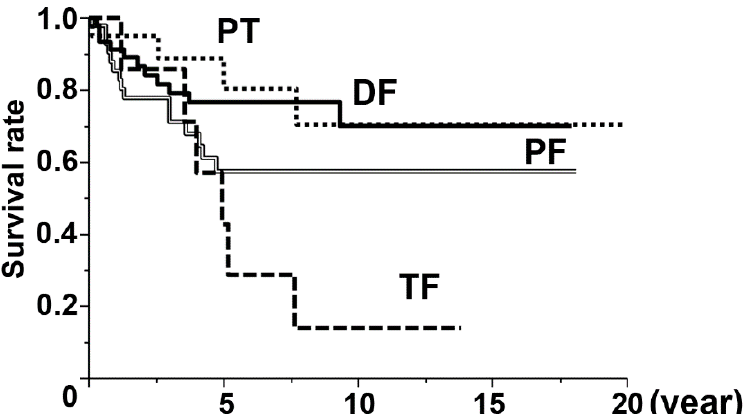
Figure 1. Overall survival of 121 patients who underwent each type of tumor prosthesis. The 5-year and 10-year survival rates were 43% and 14% (Total Femur [TF], long dotted line), 58% and 58% (Proximal Femur [PF], double line), 76% and 70% (Distal Femur [DF], solid line), and 81% and 71% (Proximal Tibia [PT], short dotted line), respectively.